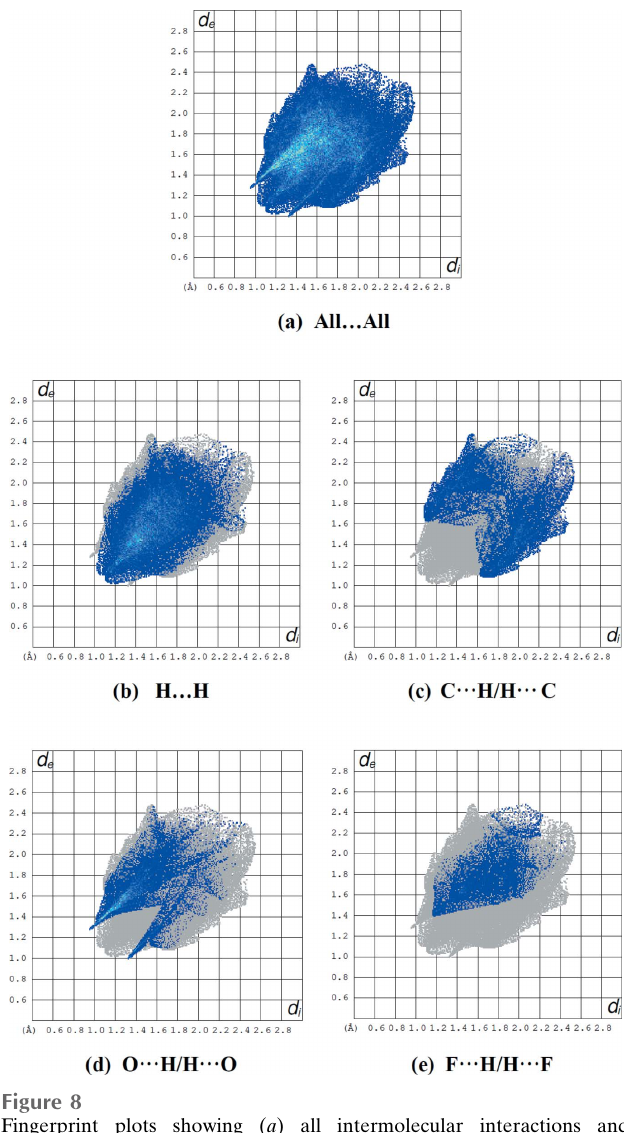
Figure 7 Hirshfeld surface of the title molecule 1 mapped over d norm .